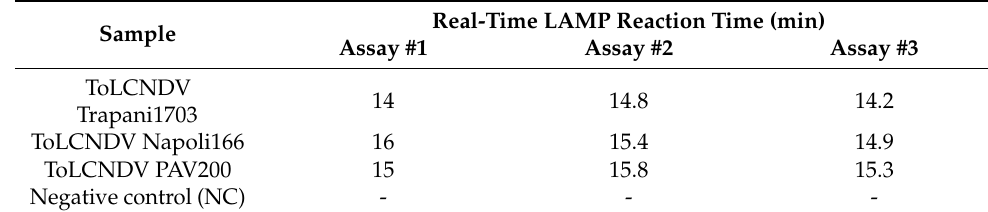
Table 3. Real-time LAMP assay performance for ToLCNDV detection.